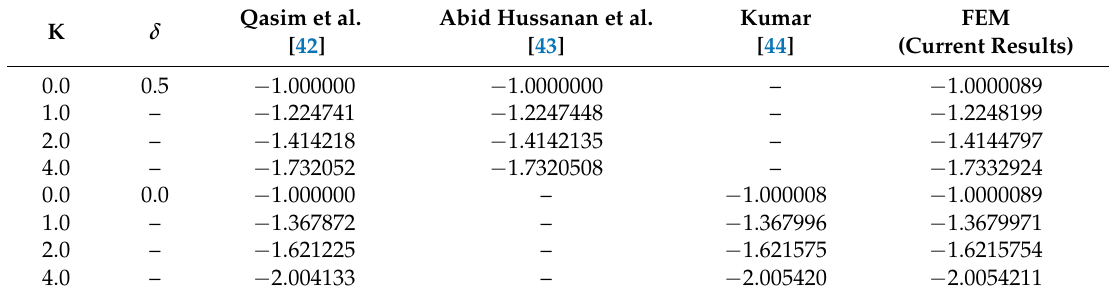
Table 4. Comparison of skin friction for different values of micro-rotation parameter K and boundary parameter δ , when all others parameters are